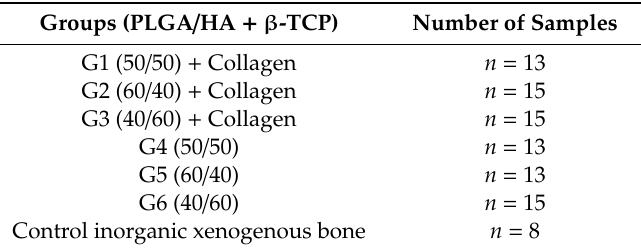
Table 1. Experimental groups